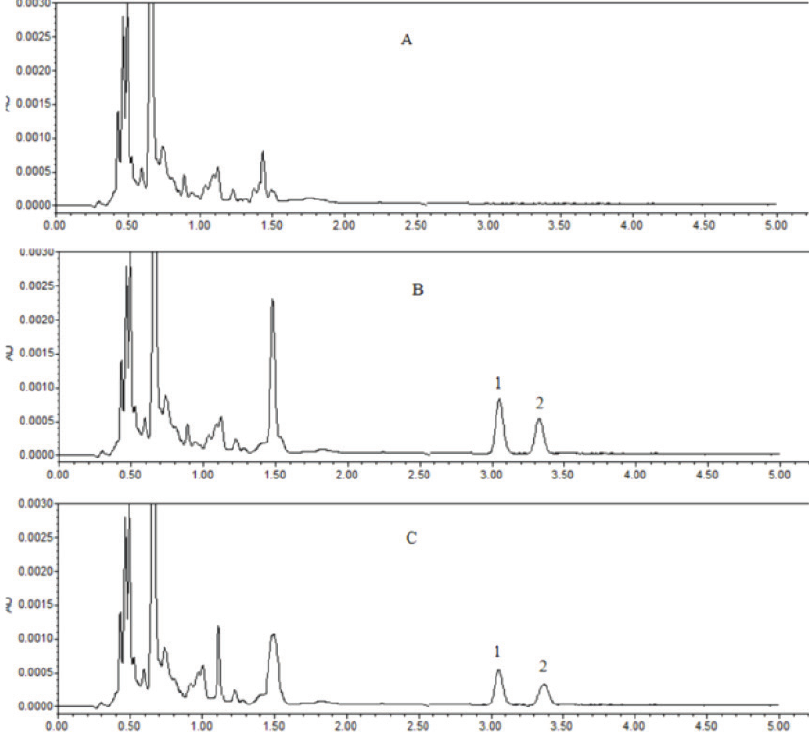
FIGURE 4 - UPLC chromatograms of (A) blank blood sample, (B) blank blood sample spiked with tacrolimus and ascomycin, (C) the blood sample after oral administration of tacrolimus-CSP. 1: ascomycin; 2: tacrolimus.